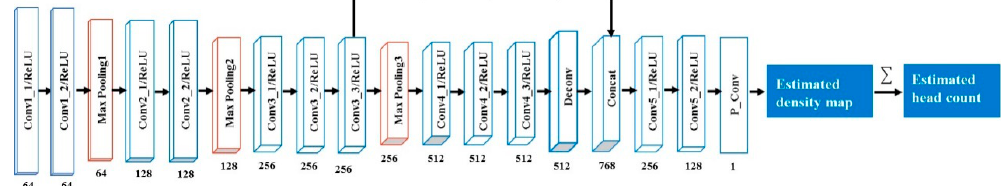
Figure 3. FF-CNN network architecture. FF-CNN: Feature Fusion of Convolutional Neural Network.